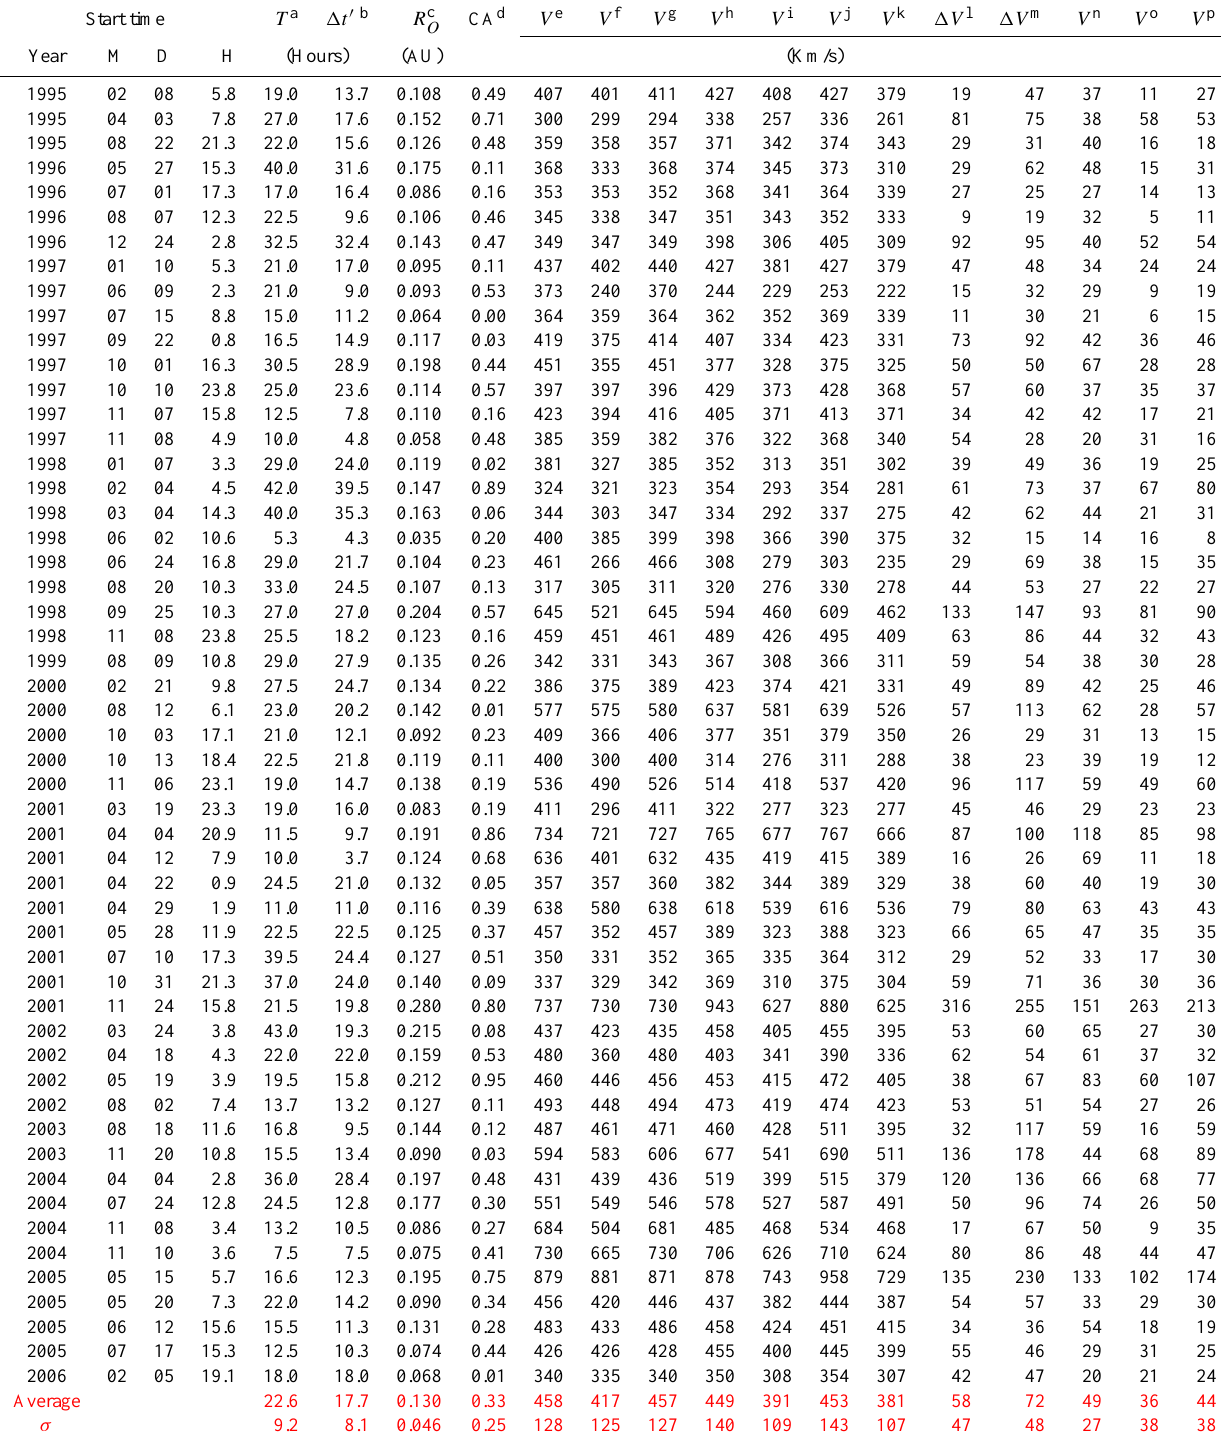
Table 1. Magnetic cloud parameter